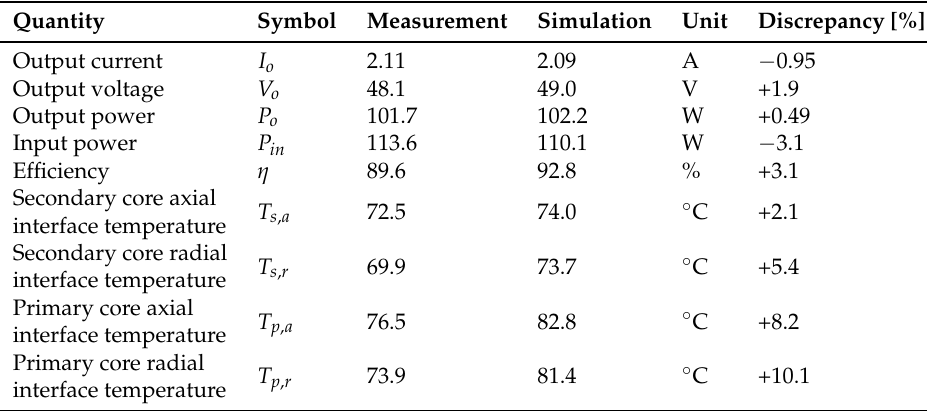
Table 3. Comparison of simulation and measurement